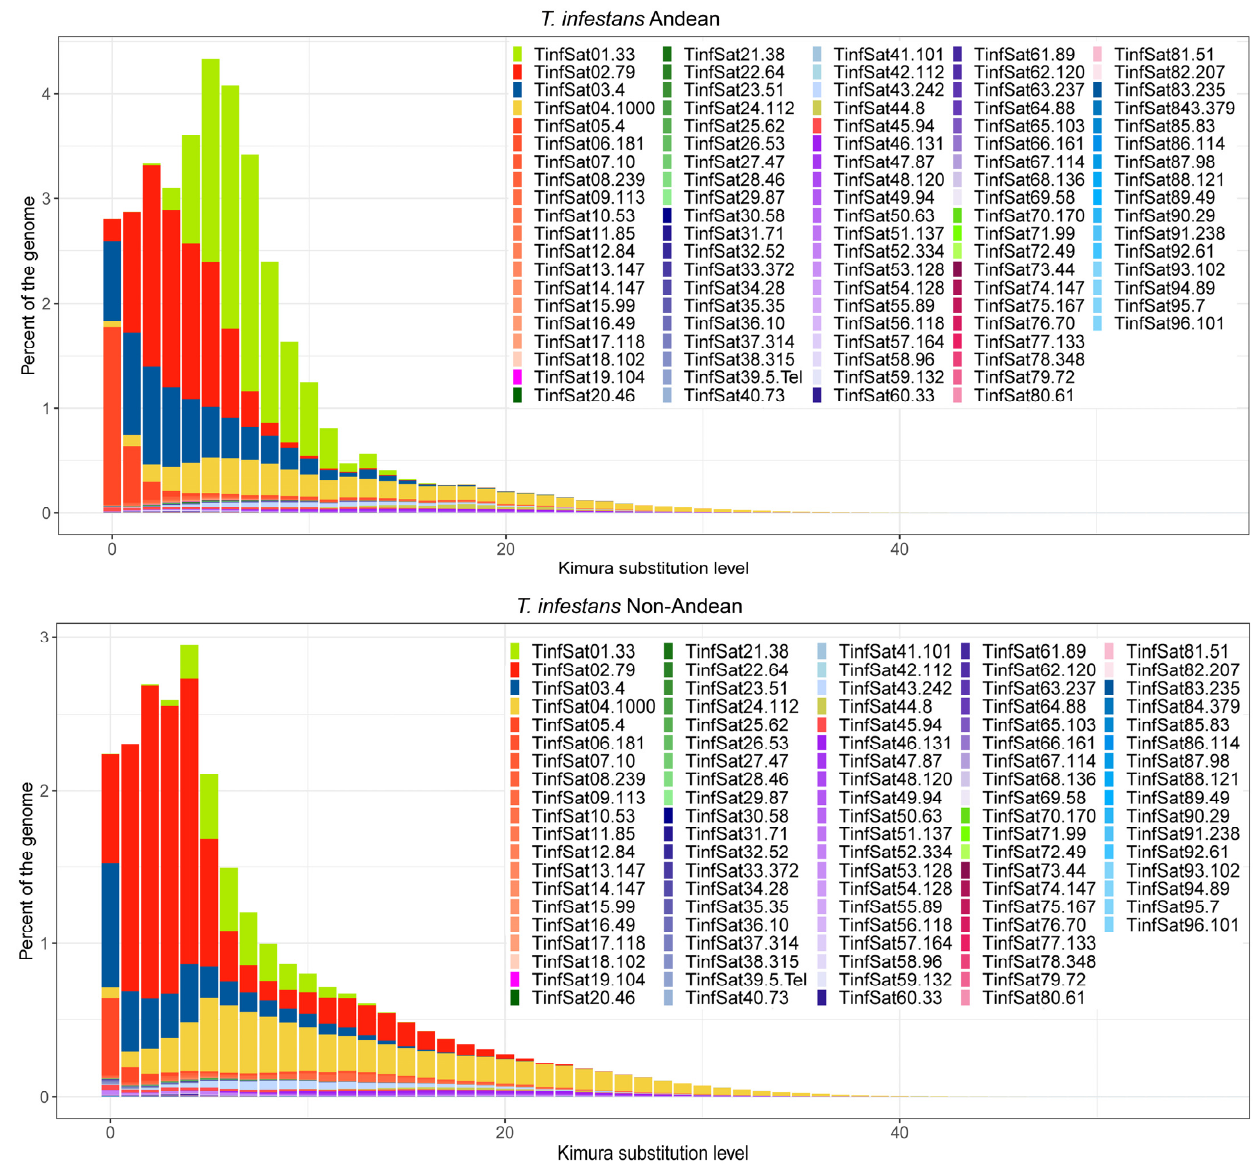
Figure 3. Satellite DNA landscapes for Andean and non-Andean T. infestans .